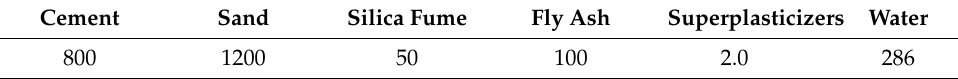
Table 6. Cement mortar mix (kg/m 3